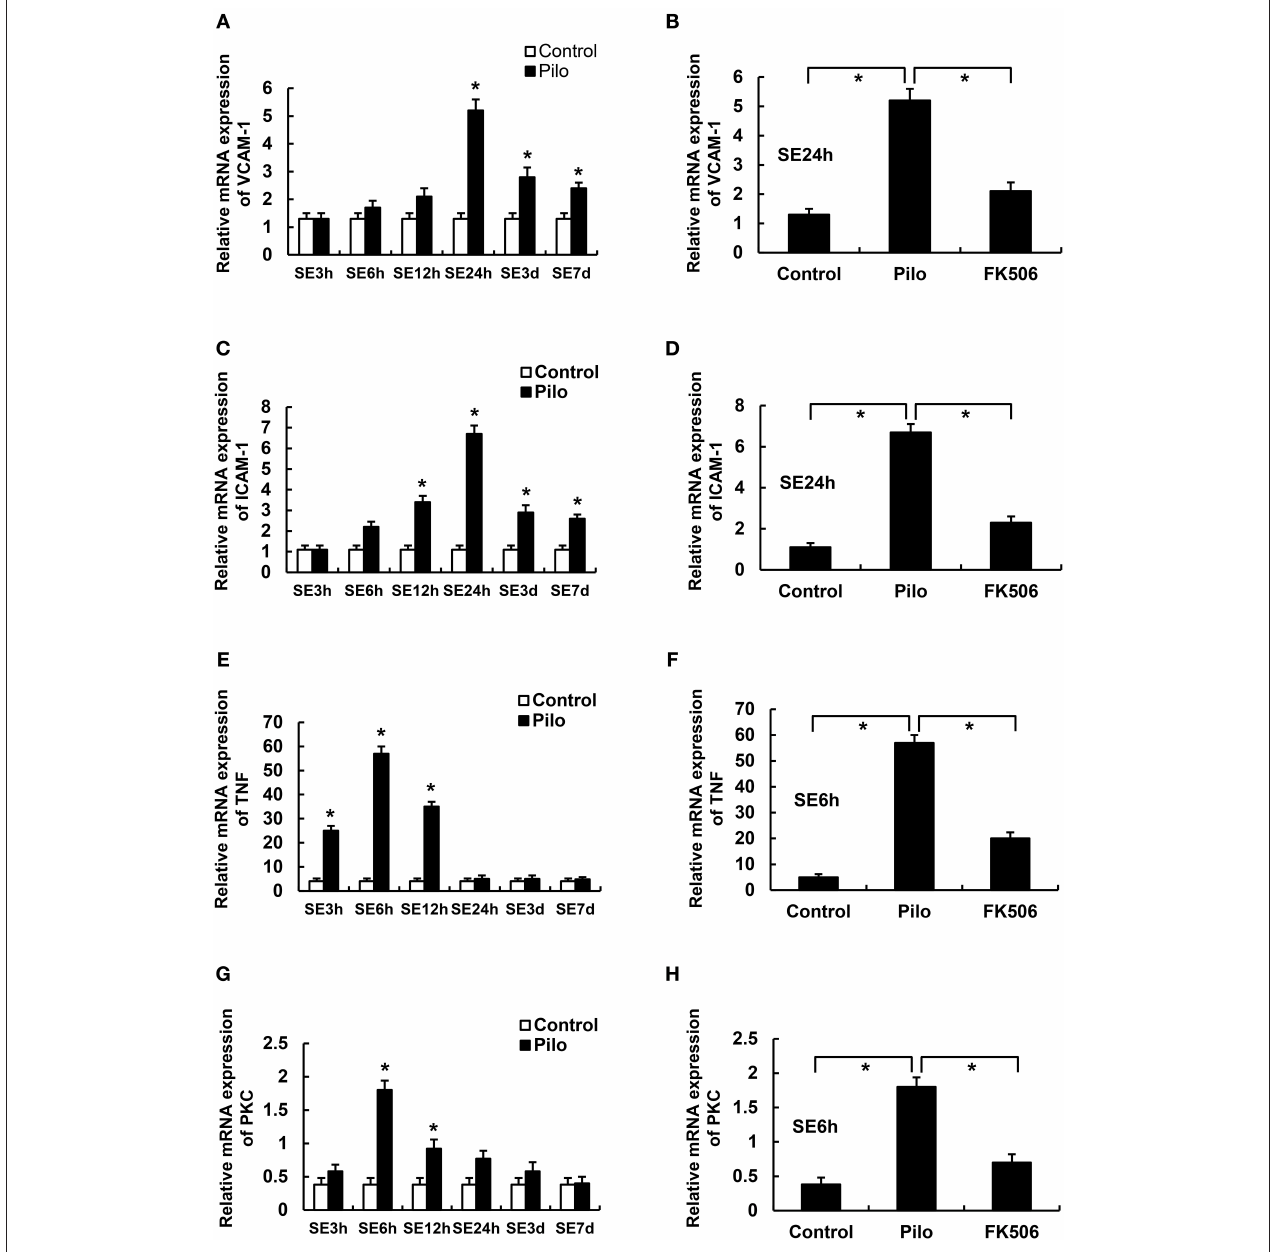
FIGURE 3 | The RNA levels of VCAM-1, ICAM-1, PKC δ , and TNF in the hippocampus of different treatment groups. (A) VCAM-1 changes at different time points in the control group and the epilepsy group. (B) VCAM-1 changes in the control group, epilepsy group, and FK506 group after 24h of modeling. (C) ICAM-1 changes at different time points in the control group and the epilepsy group. (D) ICAM-1 changes in the control group, epilepsy group, and FK506 group after 24h of modeling. (E) TNF- α changes at different time points in the control group and the epilepsy group. (F) TNF- α changes in the control group, epilepsy group, and FK506 group after 6h of modeling. (G) PKC δ changes at different time points in the control group and the epilepsy group. (H) PKC δ changes in the control group, epilepsy group, and FK506 group after 6h of modeling. * P < 0.05.